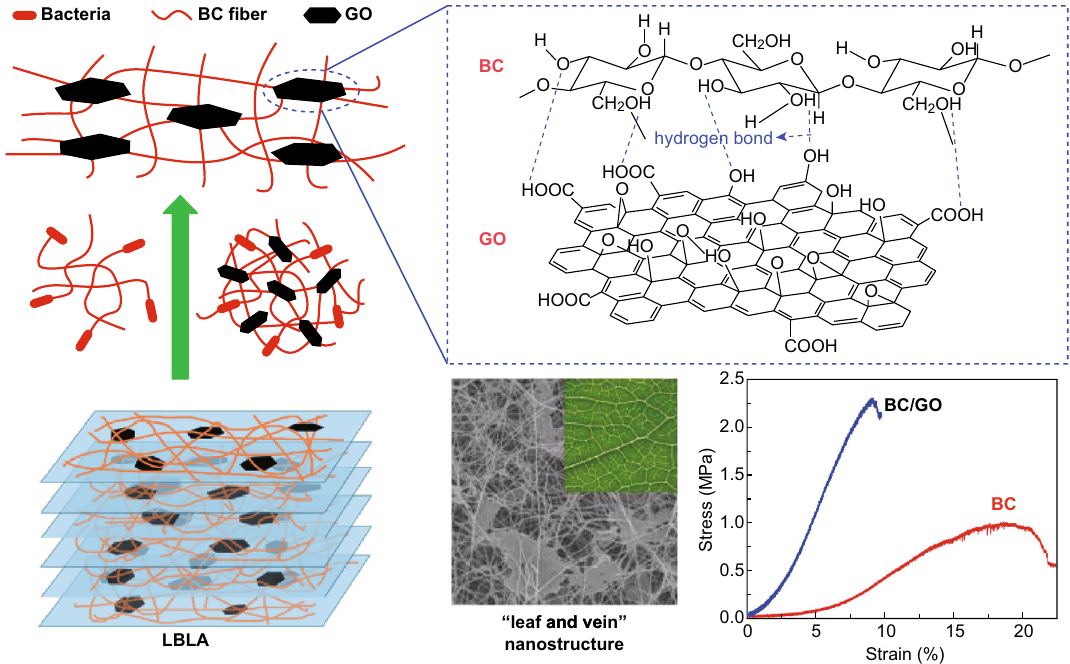
Fig. 7 Schematic diagram of ‘‘leaf and vein’’ nanostructure of BC/GO prepared by LBLA strategy. The layer-by-layer culture mode facilitates the bundling of 2D GO nanosheets by 1D BC nanofibers and promotes distribution of 2D GO nanosheets in 3D BC